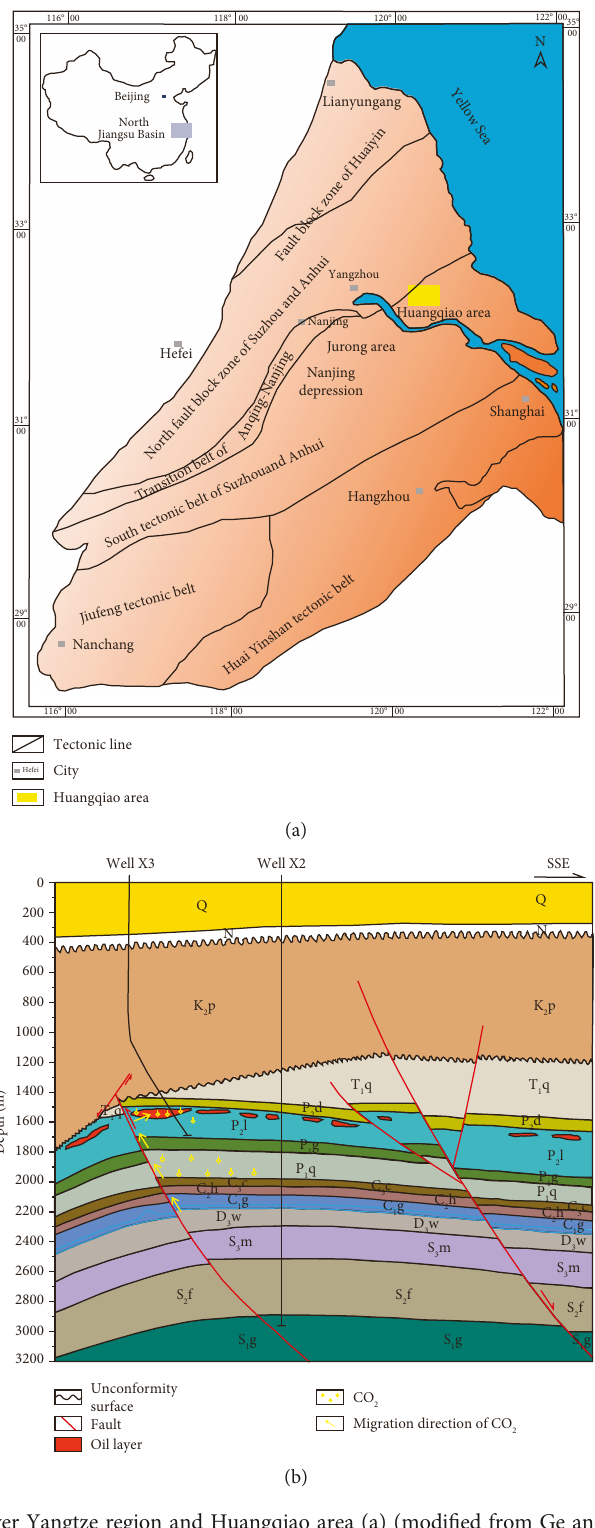
Figure 1: Tectonic units of the Lower Yangtze region and Huangqiao area (a) (modi fi ed from Ge and Zhang [37]). Simpli fi ed geological section of Well X1 and X3 (b) (from Ren et al. [35]). The meanings of the stratigraphic symbols and the lithology of the strata can be found in Figure